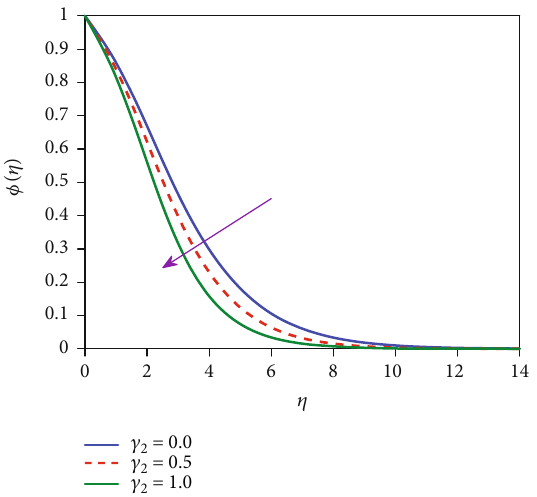
Figure 27: E ff ect of γ on the concentration ϕ ð η Þ . 2